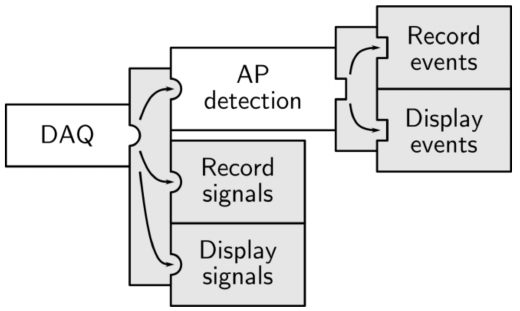
Figure 8. Multimed processing architecture for the detection and recording of neural spiking